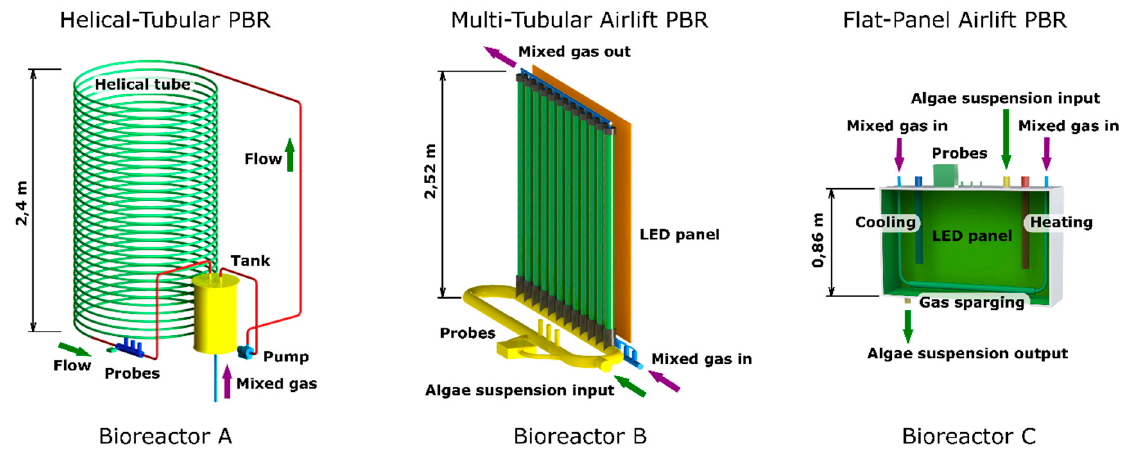
Figure 1. Schematic representation of design of the three photobioreactors used in this study: Helical-tubular PBR ( Bioreactor A ), Multi-tubular airlift PBR ( Bioreactor B ) and Flat panel PBR ( Bioreactor C ). Green parts of each PBR represent sunlight illuminated zones, yellow parts in Helical-Tubular Photobioreactor (H-T PBR), and Multi-Tubular Airlift photobioreactor (MTA PBR) represent dark zones. Total volumes of H-T PBR, MTA PBR, and Flat-Panel Airlift Photobioreactor FPA PBR were 200 L, 60 L and 25 L, respectively. LED panel in FPA PBR was placed at the back side of the cultivation tank.